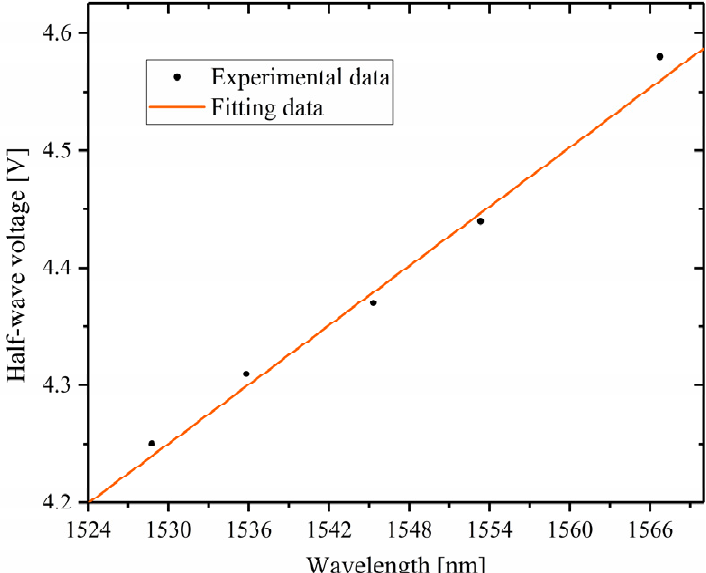
Figure 6. The half-wave voltage dispersion.